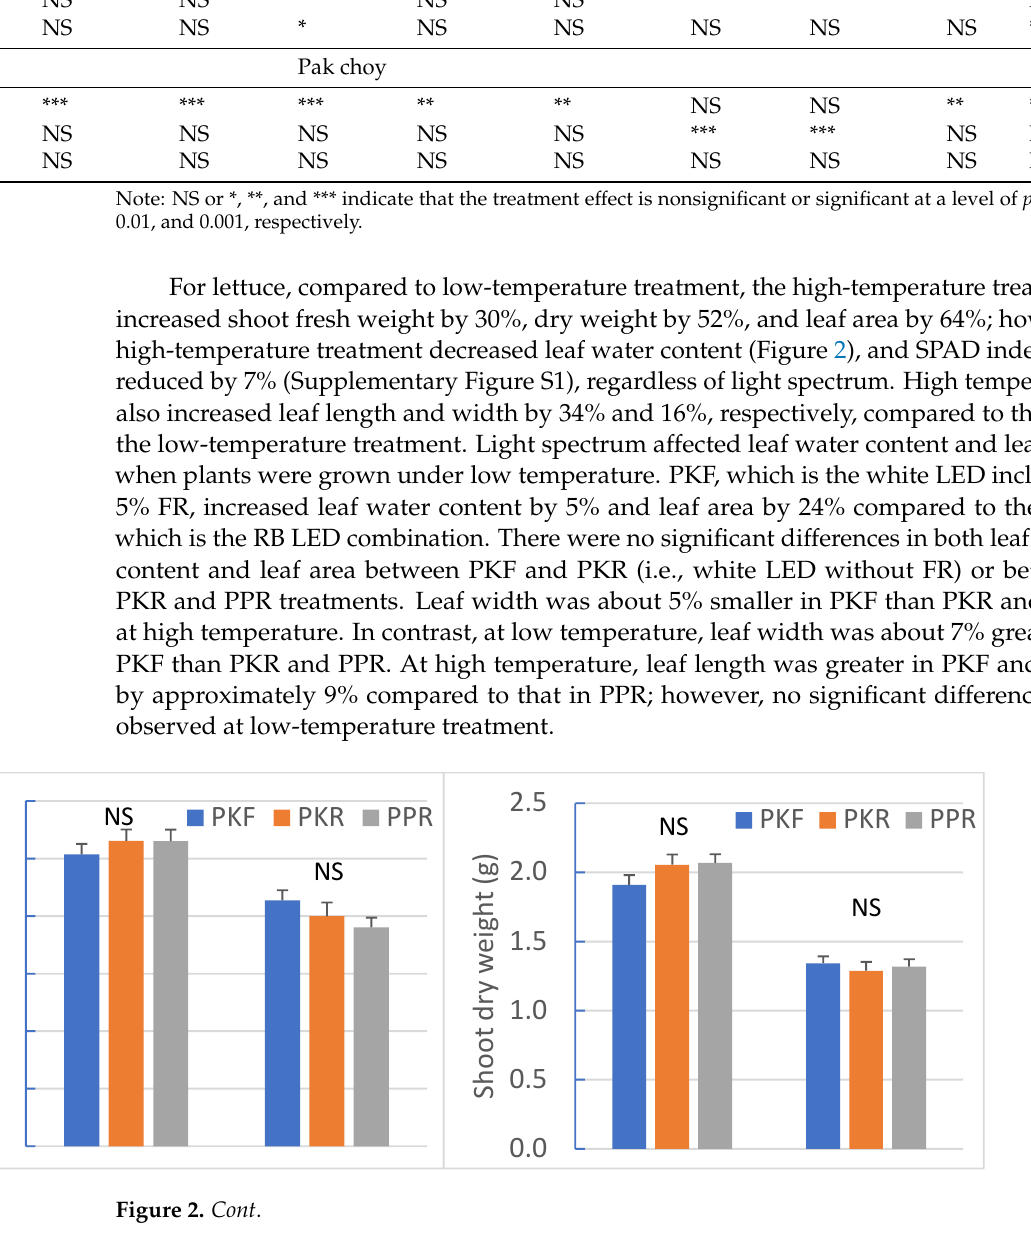
Figure 2. Shoot fresh weight, dry weight, leaf water content, leaf area, and leaf length and width of ‘Cegolaine’ lettuce ( Lactuca sativa ) plants grown under three light spectra (PKF, PKR, PPR) and two temperatures: high temperature (HT, ≈ 30 ° C) and low temperature (LT, ≈ 21 ° C). Vertical bars represent standard errors. Different letters for the same temperature level indicate significant differences among three light spectra at p ≤ 0.05. NS indicates no significant differences among the light spectra .